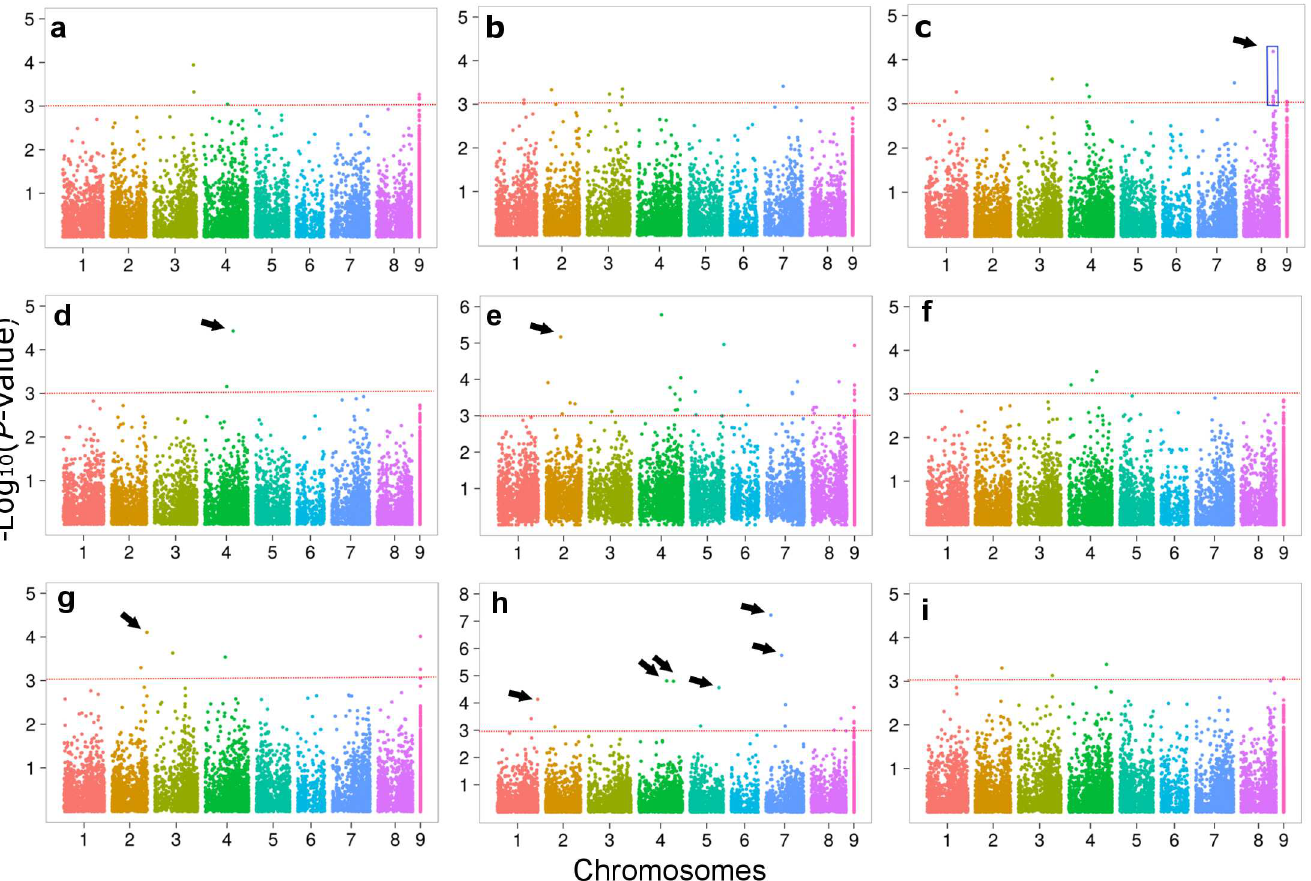
Fig 1. Manhattan plots for genome-wide association of alfalfa forage quality traits with SNP markers. Traits are: (a), leaf-to-stem ratio; (b), leaf neutral detergent fiber; (c), leaf acid detergentlignin; (d), leaf crude protein; (e) leaf in vitro NDF digestibilityat 24 hours; (f), stem neutral detergentfiber; (g), stem acid detergentlignin; (h), stem crude protein; (i) stem in vitro NDF digestibility at 24 hours. Red lines (positionedat 3.0) indicatethe minimum threshold to select significantmarkers (listed in S1 Table). The bluebox in (c) highlightsa portion of chromosome8 with high concentration of significant associations. Arrows highlightmajor associations whose definitionis given in Table 3. Marker positionswere basedon the reference genomeof M . truncatula Mt4 . 0v1 (SNPs not aligningwere placed on a fictitious chromosome 9).